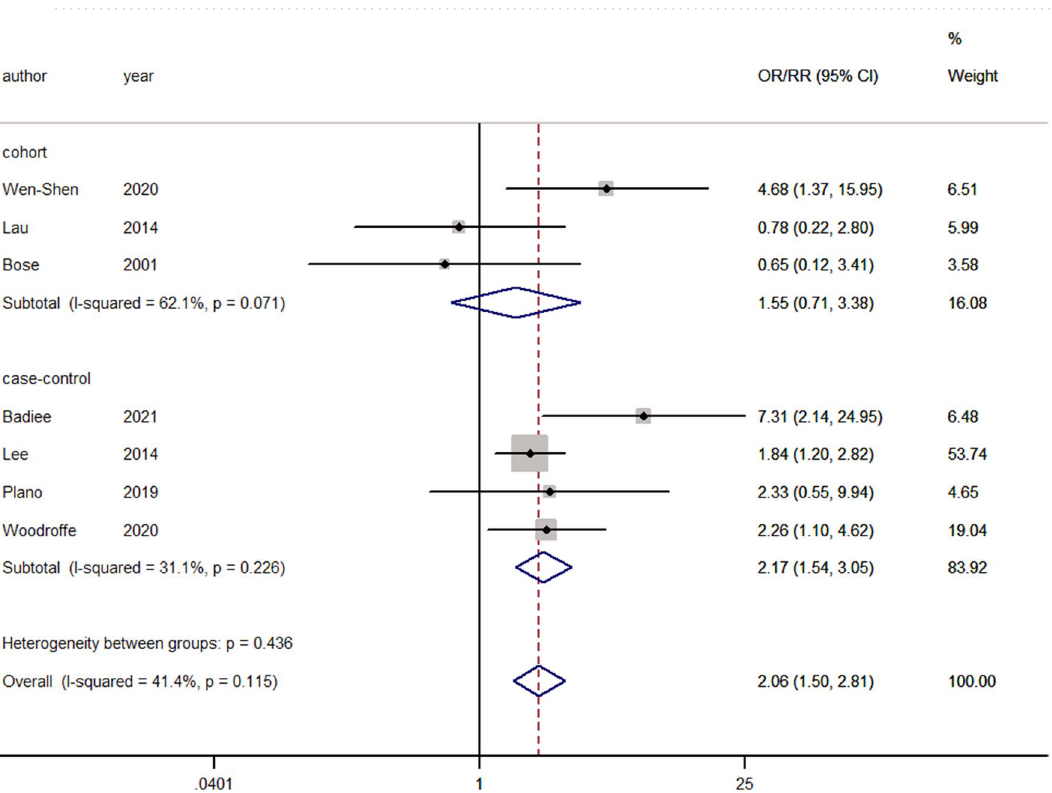
Figure 4. Forest plot showing the effect of smoking on reoperation. OR, odd rate; RR, risk rate; CI, confidence